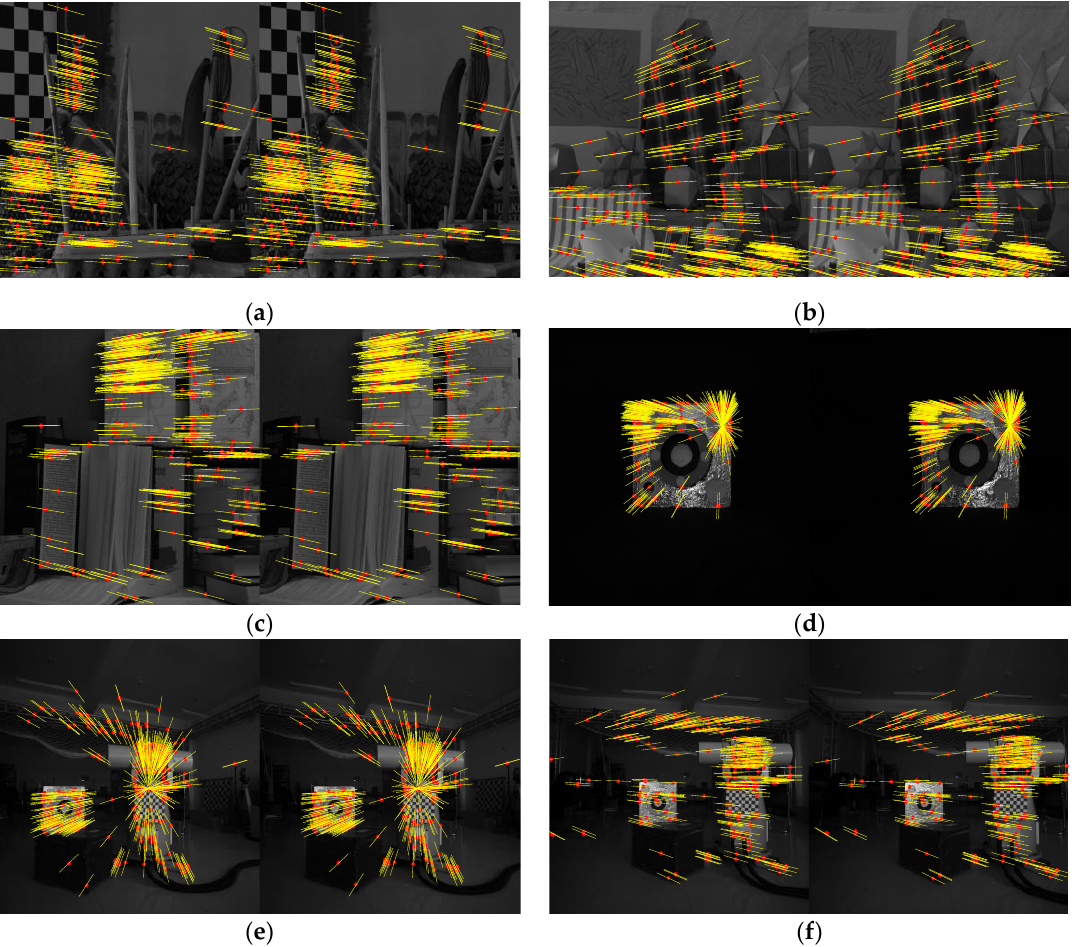
Figure 7. The epipolar geometry in different images. ( a ) Feature points and epipolar lines in Image1; ( b ) Feature points and epipolar lines in Image2; ( c ) Feature points and epipolar lines in Image3; ( d ) Feature points and epipolar lines in Image4; ( e ) Feature points and epipolar lines in Image5; ( f ) Feature points and epipolar lines in Image6. Table 3. The mean epipolar geometric distance of real images (pixel).